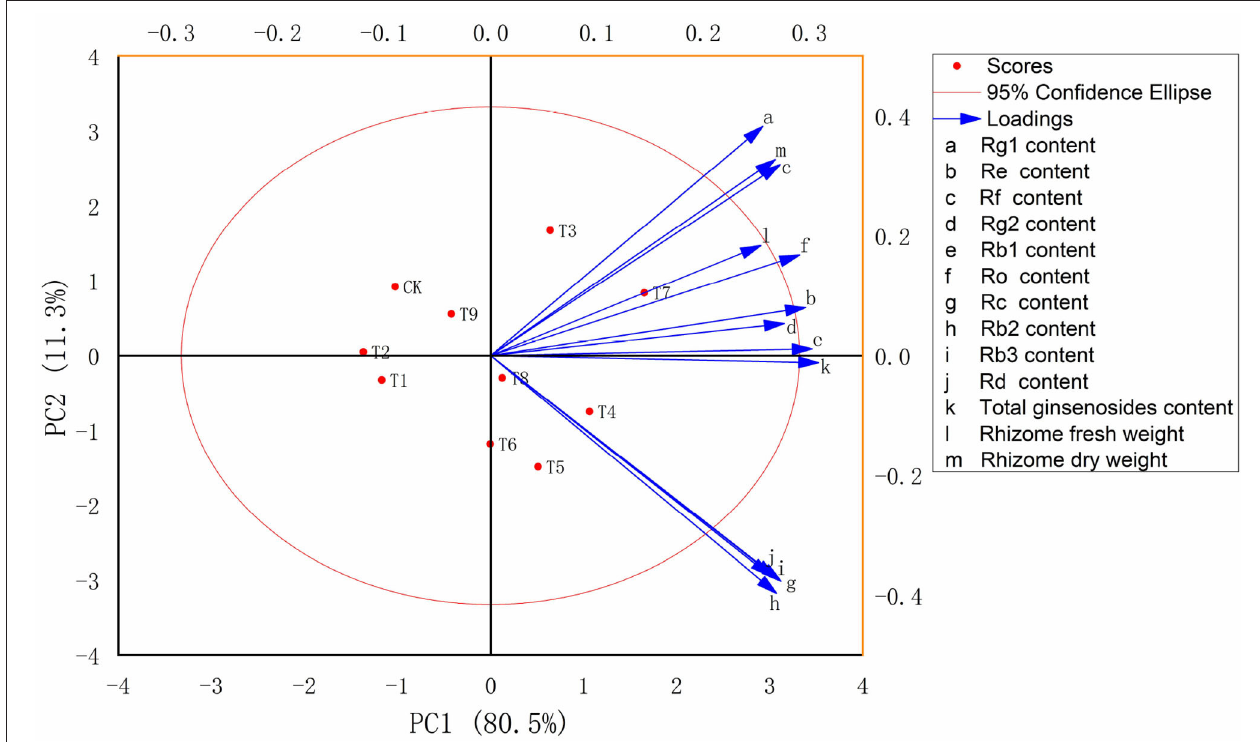
FIGURE 3 | Multi-index principal component (PC) analysis score map of ginseng in 10 fertilization treatments ( n = 10). Note: (a) Composition of fertilization treatments: CK, N 0 P 0 K 0 ; T1, N 1 P 1 K 1 ; T2, N 1 P 2 K 2 ; T3, N 1 P 3 K 3 ; T4, N 2 P 1 K 2 ; T5, N 2 P 2 K 3 ; T6, N 2 P 3 K 1 ; T7, N 3 P 1 K 3 ; T8, N 3 P 2 K 1 ; T9, N 3 P 3 K 2